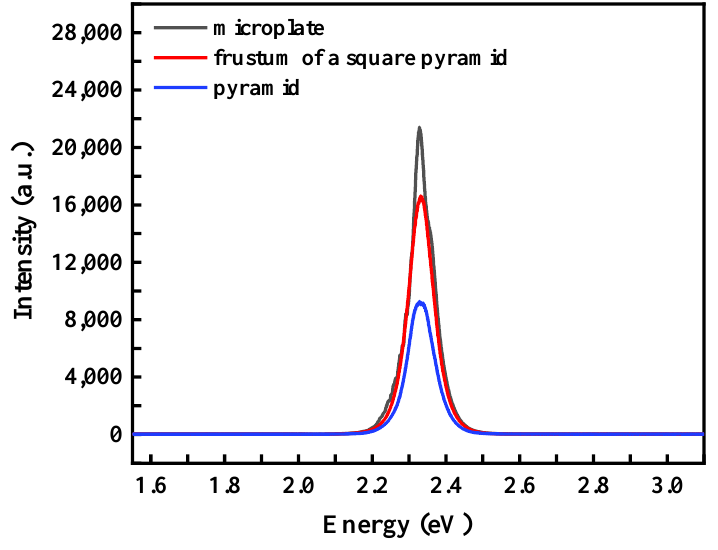
Figure 8. The PL spectra of the CsPbBr 3 microplate, frustum of a square pyramid, and pyramid.